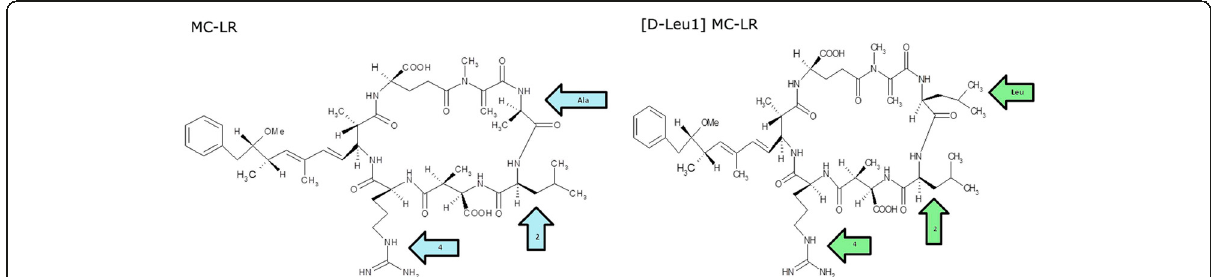
Figure 1 General structure of microcystins (LR) with leucine (L) in the amino acid position 2 and arginine (R) in the amino acid position 4 and the structural differences in the position 1 of MC-LR (left) and [D-Leu 1 ] MC-LR